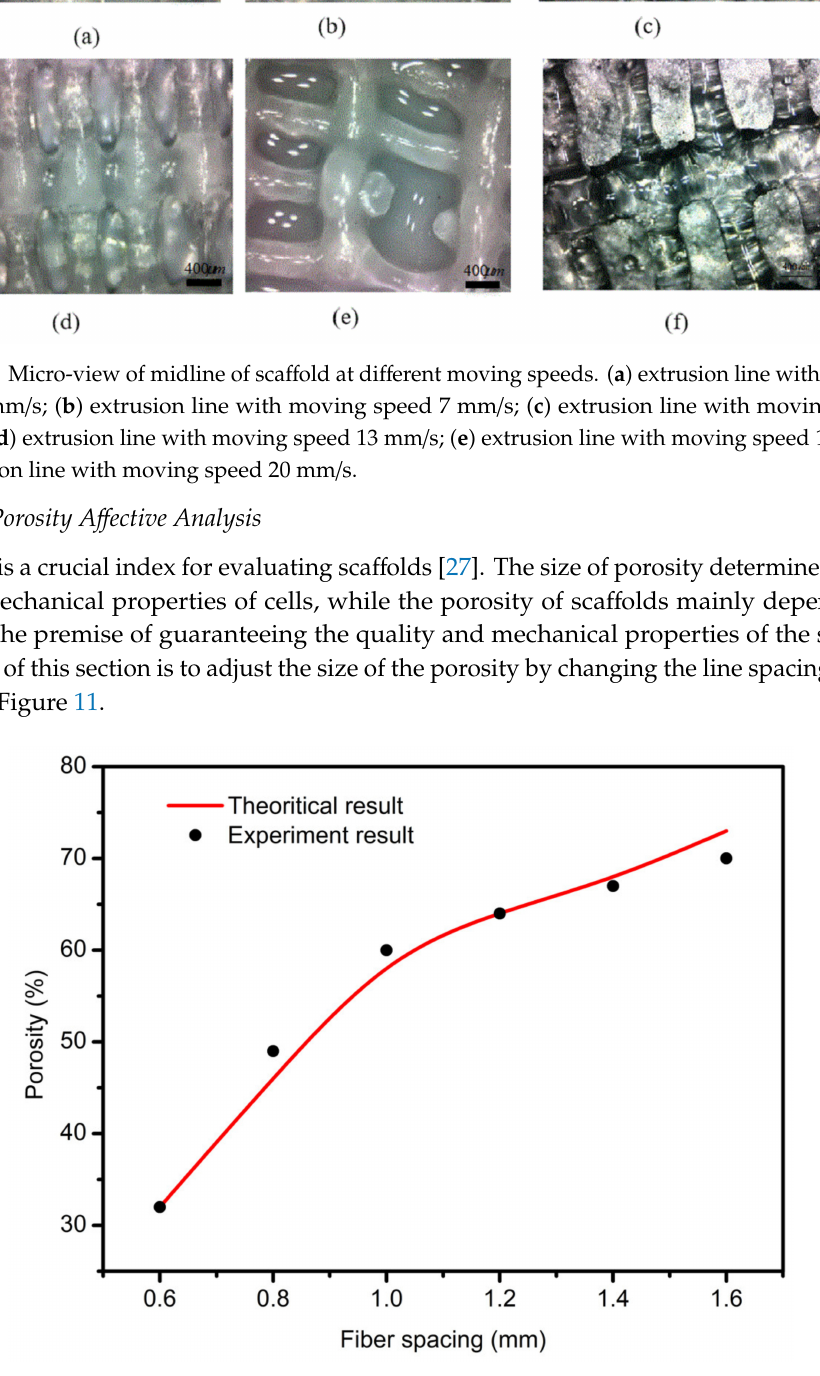
Figure 11. The relationship between fiber spacing and